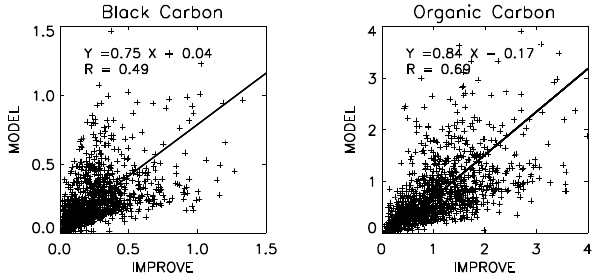
Figure 2. Scatter plot of simulated versus observed BC concentra- tions (left) and OC concentrations (right). Unit is µgCm − 3 . Values are monthly means for 2007. Regression equations and correlations are shown inset. Regression is computed with reduced major axis (RMA)